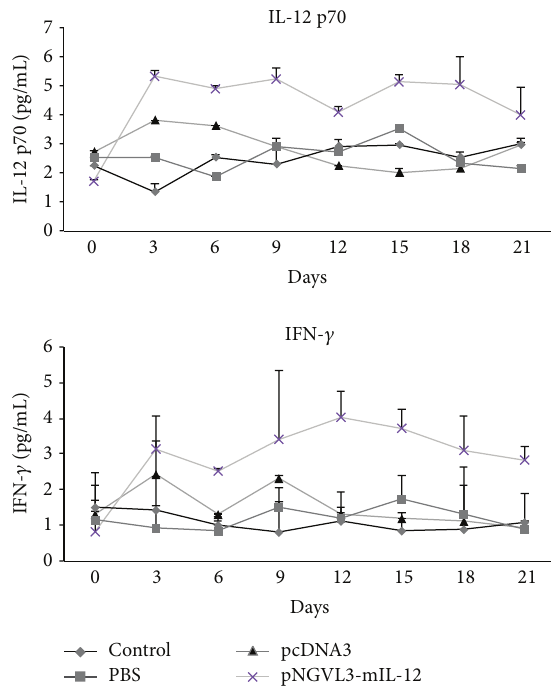
Figure 5: Levels of IL-12 (p-70) and IFN- 𝛾 . Tumor-bearing mice were treated with the IL-12 gene expression plasmid (asterisks), pcDNA3plasmid(triangle),PBS(square),ornotreatmentascontrol (diamond). Every three days following treatment, the serum was collected and by ELISA were detected the IL-12 p70 and IFN- 𝛾 proteins. Results represent the means ± S.E. values (error bars) of in each 5-mouse group, 𝑃 > 0.05